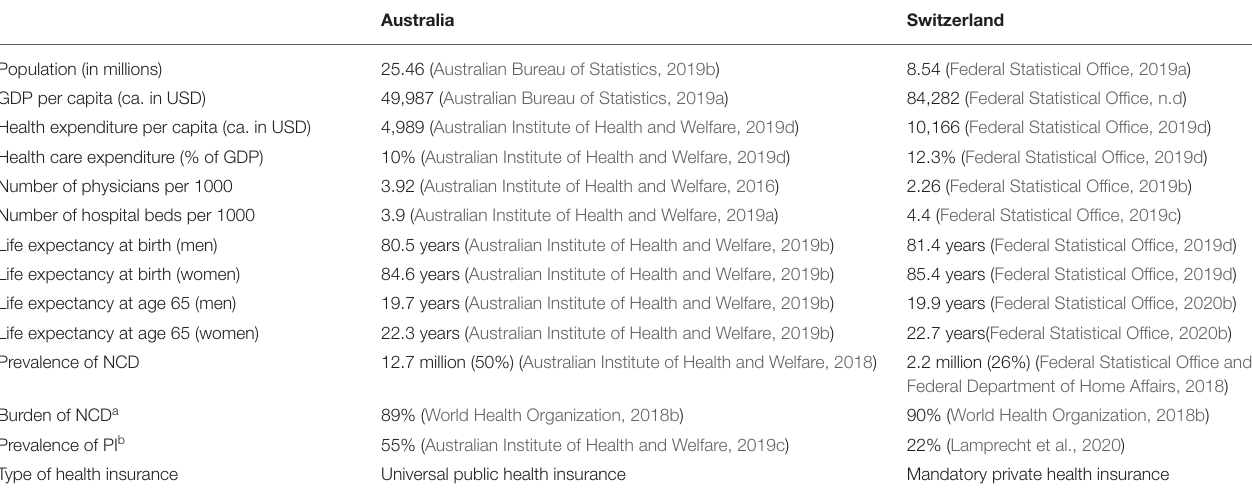
TABLE 1 | The Australian and Swiss healthcare systems by the